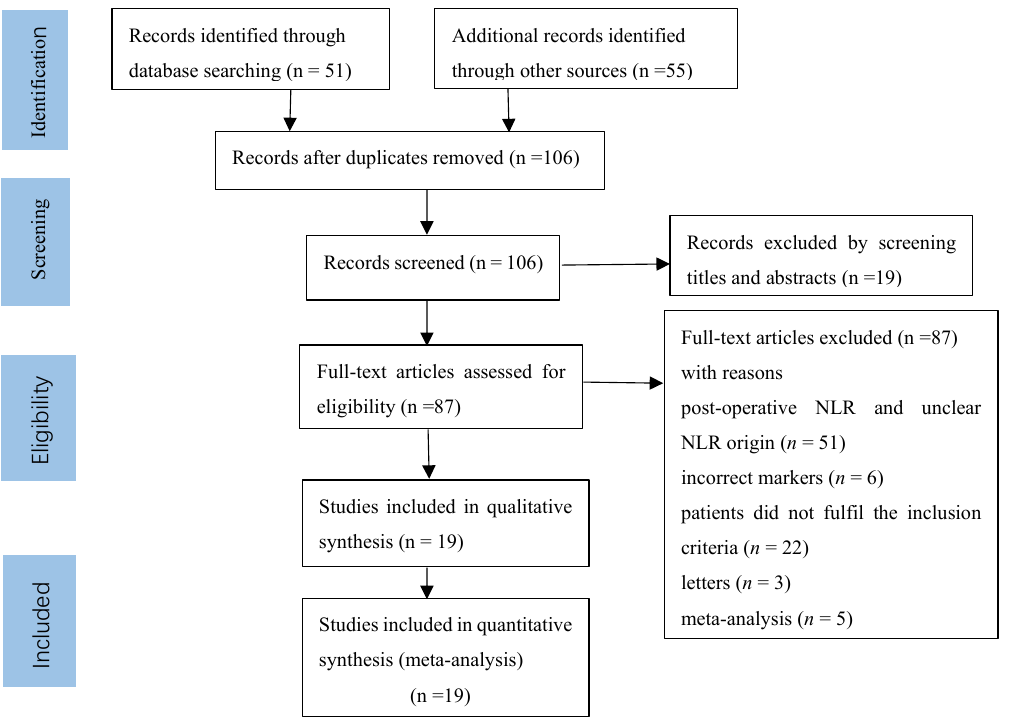
Figure1 selection process for the including studies. Figure 1. Selection process for the including